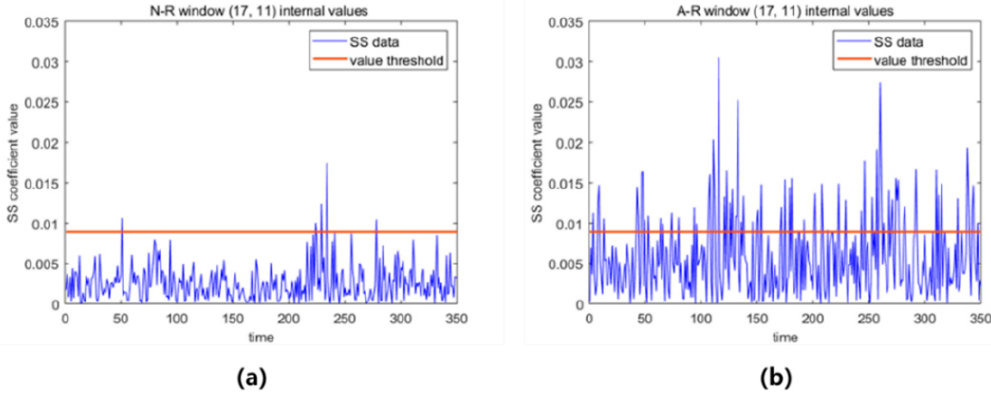
Figure 13. ( a ) N-R window (17, 11) SS coefficients of a training dataset, ( b ) A-R window (17, 11) SS coefficients of a training dataset.